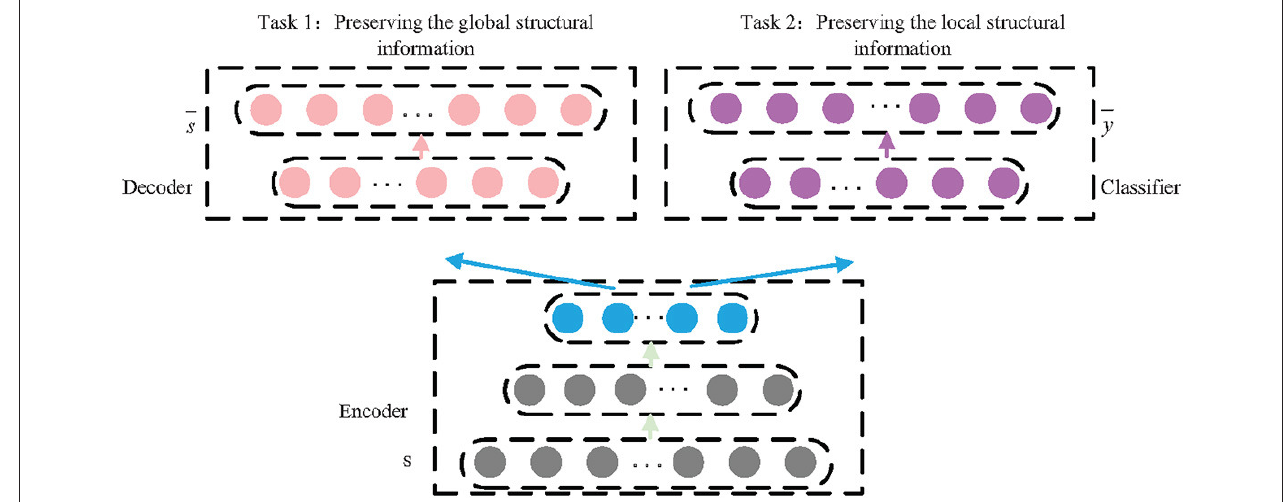
FIGURE 3 | The architecture of